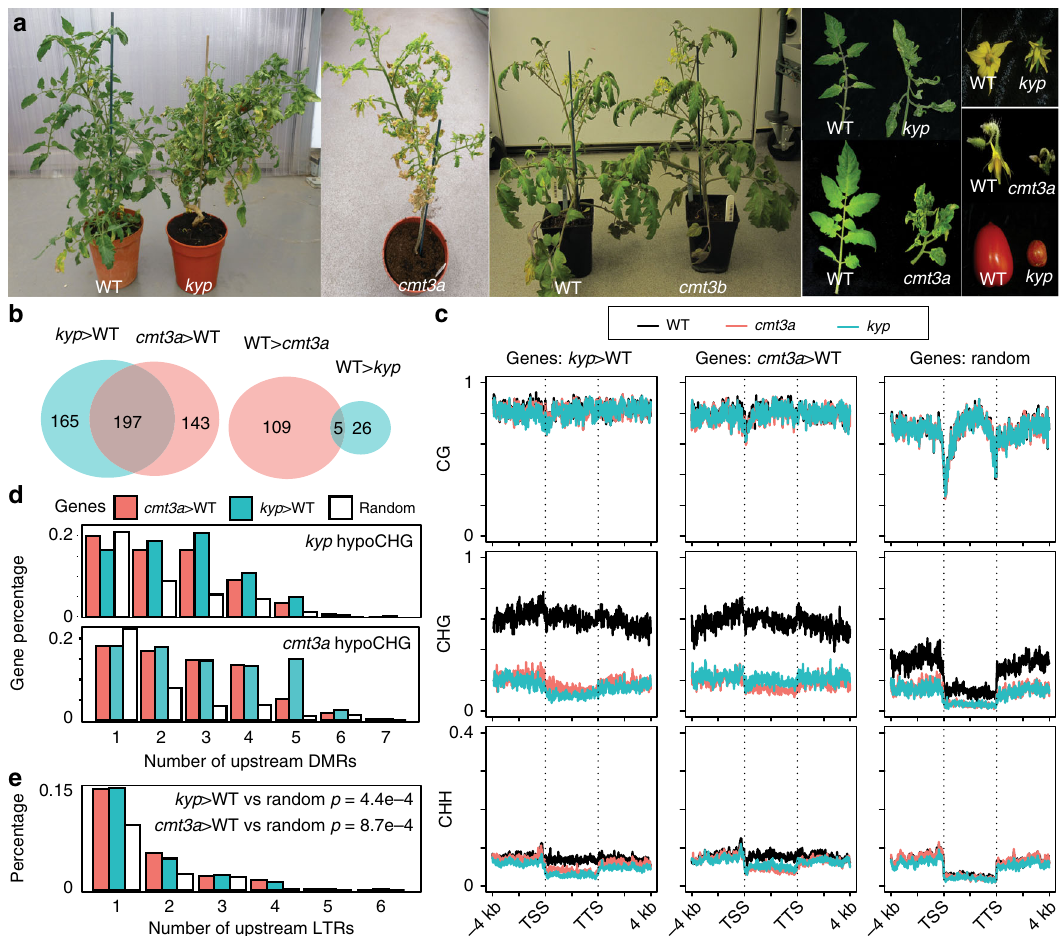
Fig. 1 SlKYP and SlCMT3a are required for tomato growth, development and reproduction. a Mutants phenotypes. One-month-old plants, leaves from a single branch, fl owers and fruits of WT and mutants were shown. b Venn diagrams showing overlap analysis of differentially expressed (DE) genes; kyp > WT, upregulated genes in kyp ; cmt3a > WT, upregulated genes in cmt3a ; WT > cmt3a , downregulated genes in cmt3a ; WT > kyp , downregulated genes in kyp . The upregulated genes are not mis-annotated TEs because 271 of 340 cmt3a -upregulated genes and 289 of 362 kyp -upregulated genes are well annotated protein-coding sequences with high con fi dence (Supplementary Data 1 and 2). c Average DNA methylation levels across DE genes or random genes and fl anking regions in WT and mutants. TSS and TTS indicate transcription start site and termination site, respectively. d Number of kyp hypoCHG DMRs and cmt3a hypoCHG DMRs within upstream 2 kb regions of DE genes or random genes. Y -axis represents the percentage of genes that have different numbers of DMRs in their upstream 2 kb regions. e Number of LTR TEs within upstream 2 kb regions of DE genes or random genes. Y -axis represents the percentage of genes that have different numbers of LTRs in their upstream 2 kb regions. T-tests are performed between DE genes and random genes and p-values are